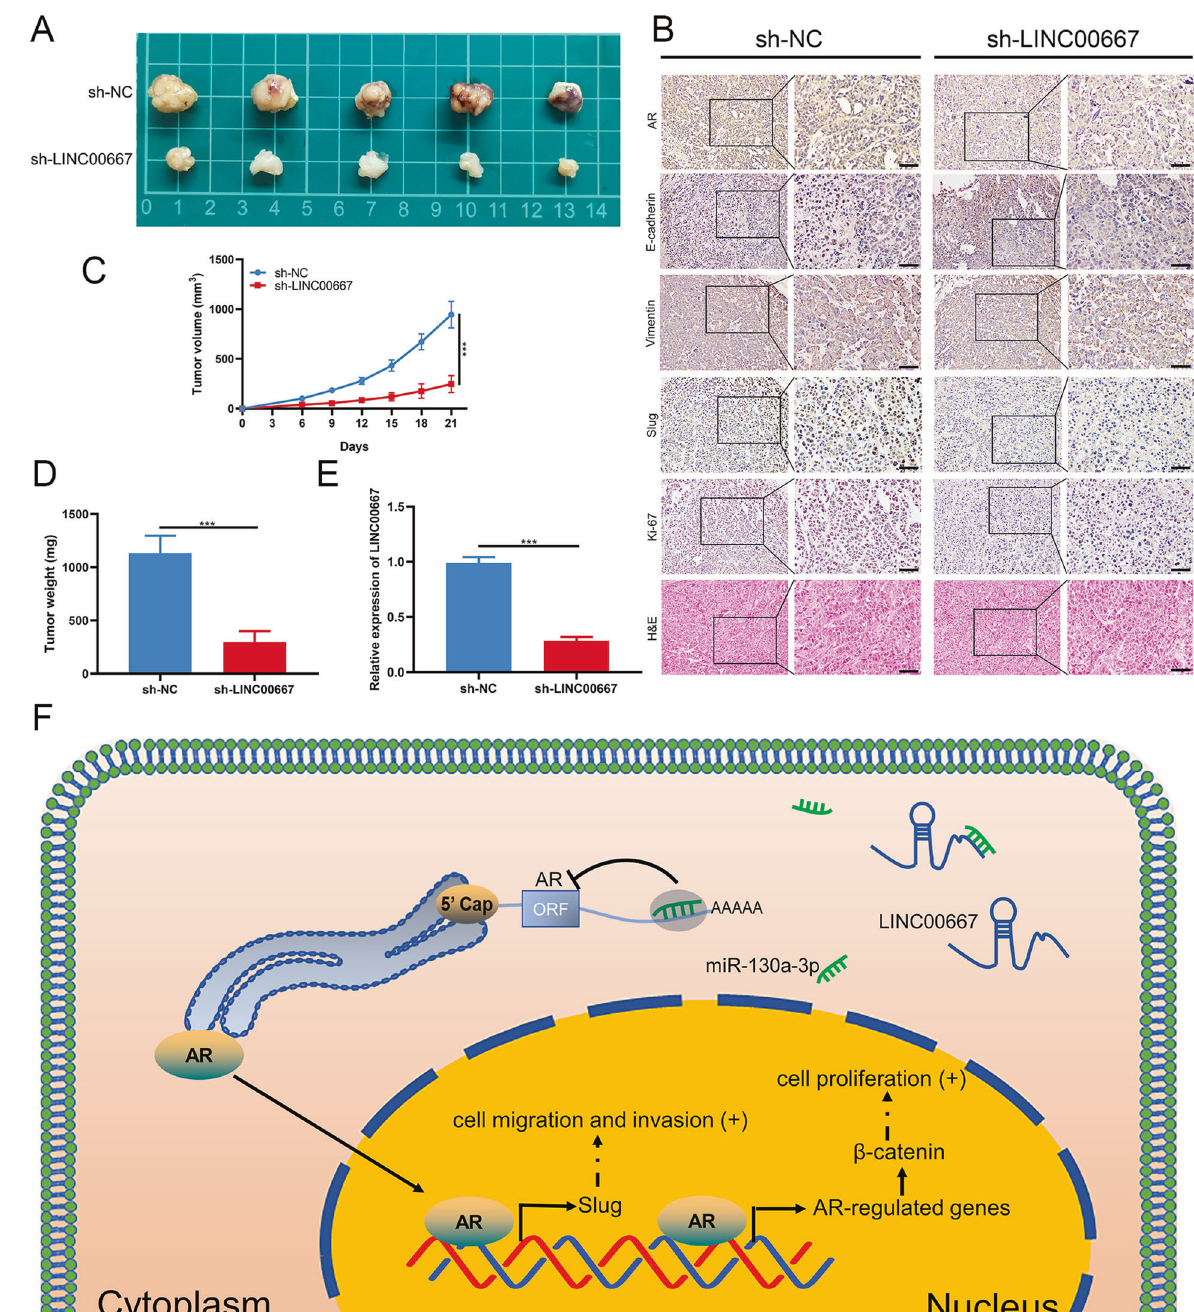
Fig. 6 LINC00667 knockdown suppresses the growth of HCC in vivo. A Nude mice were injected subcutaneously with sh-LINC00667 or sh- NC-transfected HCCLM3 cells ( n = 5 per group, student ’ s t test). Image of STTs in sh-LINC00667 and sh-NC groups. B Relative expression levels of AR, E-cadherin, Vimentin, Slug and Ki-67 in STTs were detected by immunostaining. HE staining image of STTs in sh-LINC00667 and sh-NC groups. Scale bar, 100 μ m. C Tumor volume curves of mice were monitored every 3 days. Data were analyzed by student ’ s t test. D The subcutaneous tumor weights were determined at the 21st day. Data were analyzed by student ’ s t test. E Relative expression of LINC00667 in STTs was detected by RT-qPCR. Data were analyzed by student ’ s t test. F Schematic diagram showing the mechanisms by which LINC00667 acts as a miRNA-130a-3p sponge to promote AR expression during HCC progression. Data, mean ± S.D. *** P < upregulated in many kinds of cancers such as colorectal cancer DISCUSSION [39] and lung cancer [40] as well as nasopharyngeal carcinoma [41]. Long noncoding RNAs are involved in the biological process of However, the roles of LINC00667 in HCC remain largely unclear. various tumors, including HCC. For example, lncRNA AY promoted Here, we demonstrated LINC00667 could regulate the cellular HCC metastasis by inducing ITGAV transcription [37], and lncRNA- proliferation and migration of HCC both in vitro and in vivo, and PDPK2P promoted the progression of HCC via PDK1/AKT/caspase 3 delineated the signaling pathway responsible for the interaction axis [38]. It has been reported that LncRNA LINC00667 is